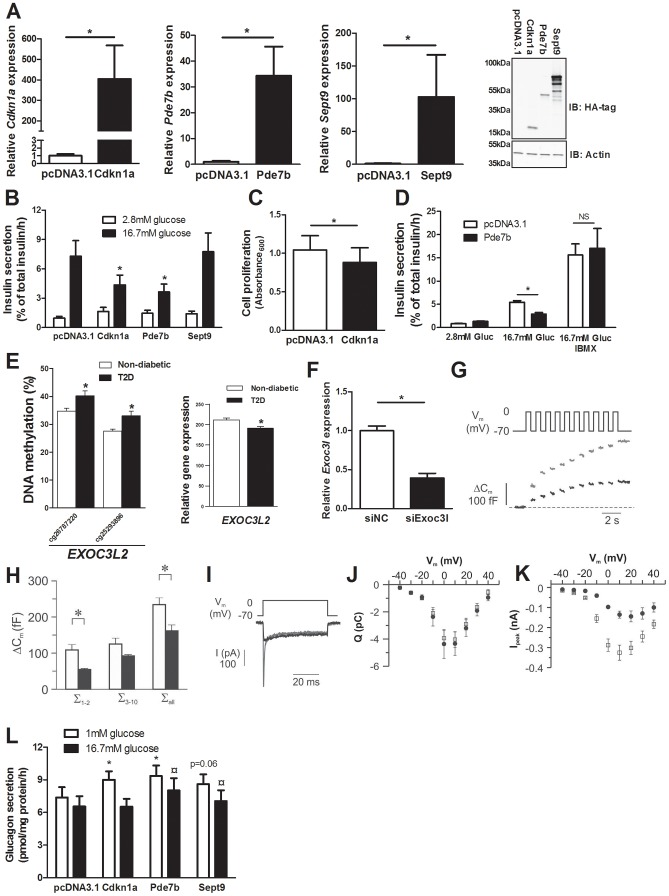
Impact of Cdkn1a, Pde7b, Sept9 and Exoc3l on clonal β- and α-cells.Glucose-sensitive clonal INS-1 832/13 β-cells were used to study the impact of Cdkn1a, Pde7b, Sept9 and Exoc3l on insulin secretion and β-cell function. (A) Overexpression of Cdkn1a, Pde7b and Sept9 with pcDNA3.1 expression vectors in clonal β-cells resulted in elevated mRNA levels (black bars) compared with β-cells transfected with an empty pcDNA3.1 vector (white bars). * P<0.05. Data are mean ± SEM. Overexpression was also evident at the protein level as determined by immunoblot detection of the HA-tag situated on the c-terminal of the cloned cDNAs (rightmost panel) (B) Insulin secretion in response to 2.8 mM (white bars) and 16.7 mM (black bars) glucose in clonal β-cells overexpressing either Cdkn1a, Pde7b or Sept9 compared with control cells transfected with an empty pcDNA3.1 vector (n = 5). * P<0.05. Data are mean ± SEM (C) Decreased cell proliferation in clonal β-cells overexpressing Cdkn1a (black bar) compared with cells transfected with an empty pcDNA3.1 vector (white bar) (n = 4). * P<0.05. Data are mean ± SEM (D) Insulin secretion in response to 2.8 mM and 16.7 mM glucose (Gluc) or 16.7 mM glucose (Gluc) in combination with 100 µM IBMX in clonal β-cells overexpressing Pde7b (black bars) compared with cells transfected with an empty pcDNA3.1 vector (white bars) (n = 3). * P<0.05. NS = not significant. (E) Increased DNA methylation and decreased mRNA expression of EXOC3L2 in pancreatic islets of 15 T2D versus 34 non-diabetic donors. (F) Transfection of clonal β-cells with siRNA targeting Exoc3l resulted in decreased Exoc3l mRNA expression (siExo3l, black bar) when compared with clonal β-cells transfected with negative control siRNA (siNC, white bar) (n = 3). * P<0.05. Silencing of Exoc3l resulted in decreased Ca2+-dependent exocytosis; (G) Depolarizationevoked a decrease in membrane capacitance (ΔCm) in single INS1-832/13 β-cells where Exoc3l was silenced (black trace) compared with control β-cells (grey trace) treated with negative control siRNA. (H) Histogram of the summed increase in membrane capacitance evoked by the two first depolarizations (Σ1–2), the latter eight depolarizations (Σ3–10) or all depolarizations in the train (Σall). Data are mean ± SEM of n = 11 β-cells treated with control siRNA (white bars) and n = 4 β-cells treated with siRNA against Exoc3l (black bars). * P<0.05. (I) Depolarization-evoked increase in current (I) in single INS1-832/13 β-cells treated with control siRNA (grey trace) or siRNA targeting Exoc3l (black trace). Notice that the rapid Na+-current is markedly diminished in siExoc3l treated clonal β-cells. (J) Reduced expression of Exoc3l has no effect on the Ca2+ influx. Charge (Q)-voltage (Vm) relationship in β-cells treated with control (white squares) siRNA and siRNA against Exoc3l (black circles). The charge is representative of the Ca2+-influx into the cell through the voltage-dependent Ca2+ channels. (K) As in J, but the peak-current (Ipeak)-voltage (Vm)-relationship was estimated as a representation of the voltage-dependent Na+ current. The Na+ current is significantly reduced in siExoc3l cells (P<0.05) versus control siRNA cells except for the depolarization to −40 mV. Data in J and K are mean ± SEM of n = 11 β-cells treated with control siRNA and n = 7 siExoc3l treated β-cells. (L) αTC1-6 cells were used to determine the impact of Cdkn1a, Pde7b and Sept9 on glucagon secretion. Overexpression of Cdkn1a and Pde7b resulted in significantly increased glucagon secretion at 1 mM glucose (white bars) (n = 4, * P<0.05), while overexpression of Pde7b and Sept9 resulted in increased glucagon secretion at 16.7 mM glucose (black bars) (n = 4, ¤ P<0.05) compared with control cells transfected with an empty pcDNA3.1 vector.